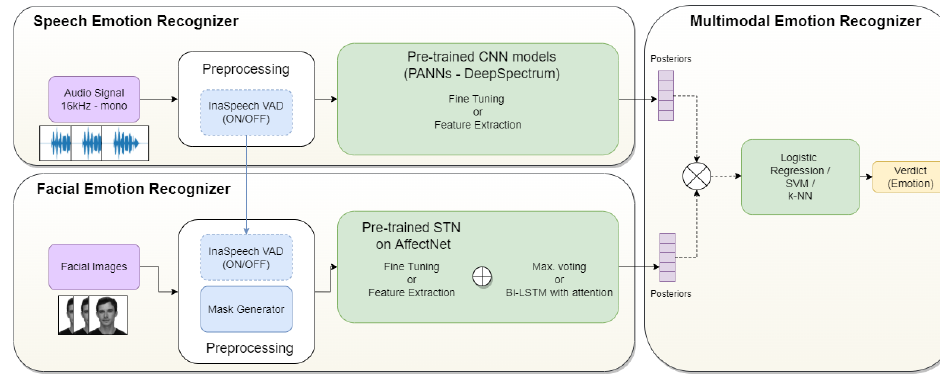
Figure 1. Block diagram of the implemented